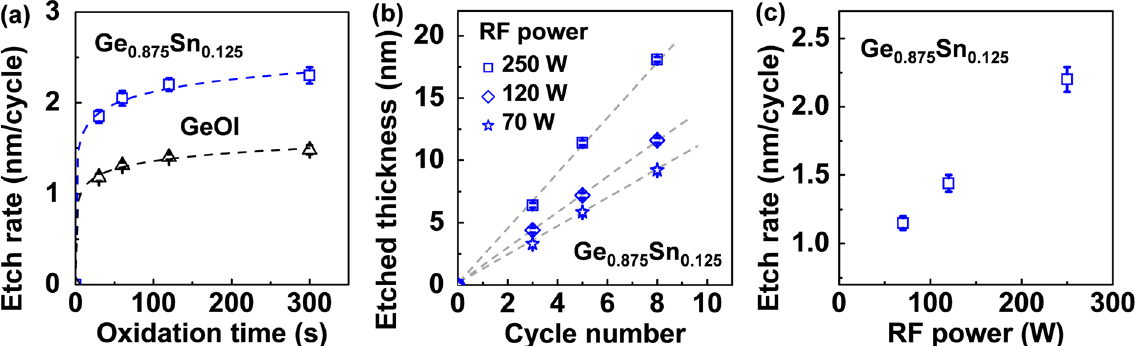
Figure 6. ( a ) Etch rate as a function of oxidation time for Ge and Ge 0.875 Sn 0.125 . The oxide layer thickness grows logarithmically with the oxidation time and saturates fast. ( b ) Etched thickness versus cycle number under different RF power and ( c ) extracted etch rate. The etch rate decreases with decreasing RF